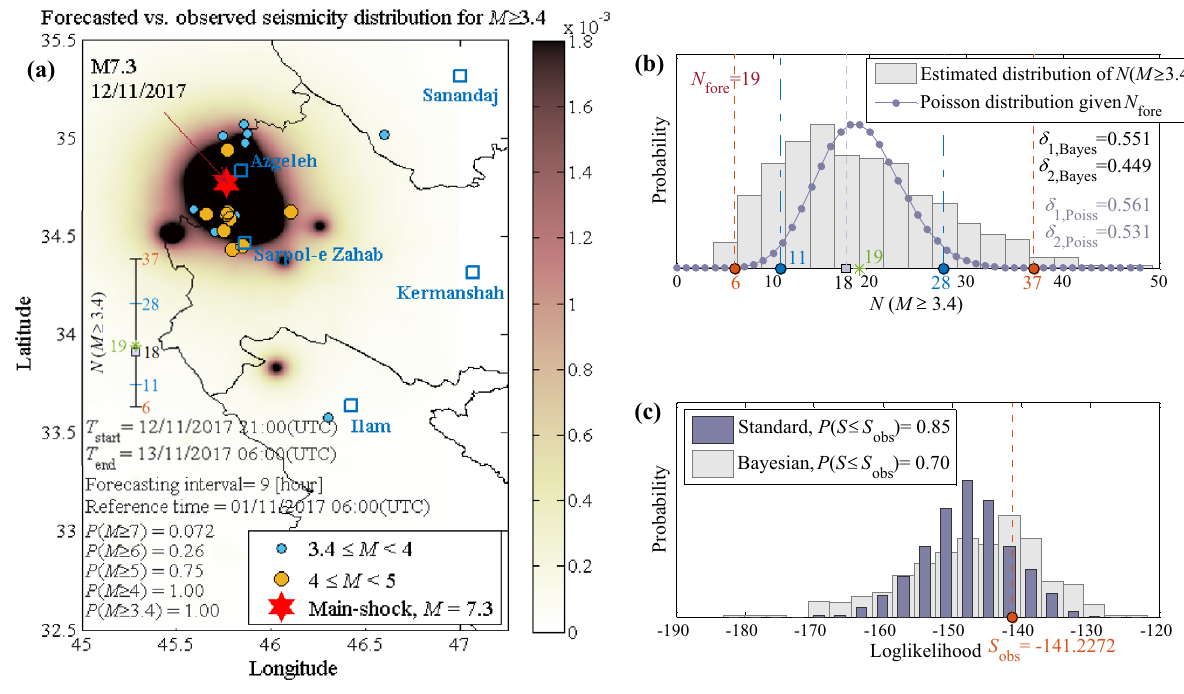
Figure 5. ( a ) The map showing forecasted vs. observed seismicity distribution in the aftershock zone for the 1st forecasting time window [ T start = 12/11/2017–21:00UTC, T end = 13/11/2017–06:00UTC] including: the expected value for the number of events in each cell unit with M ≥ 3.40; the reported P ( M ≥ m ); the earthquakes that occurred during the corresponding forecasting time window; the mainshock of M w 7.3; and bar chart showing the observed vs. the percentiles of the forecasted number of events. ( b ) N-test based on the simulation-based Bayesian workflow and the Poisson distribution; consistent with the error-bar on the left-side of ( a ), the green star shows the observed number of events within the forecasting interval (= 19), the grey-filled square is the median value or the 50th percentile (= 18); blue circles are the 16th and 84th percentiles (= 11 & 28); red circles show the 2nd and 98th percentiles (= 6 & 37); N fore = 19 is the expected number of events N ( M ≥ 3.40). (c) S-test based on the simulation-based Bayesian framework and the standard